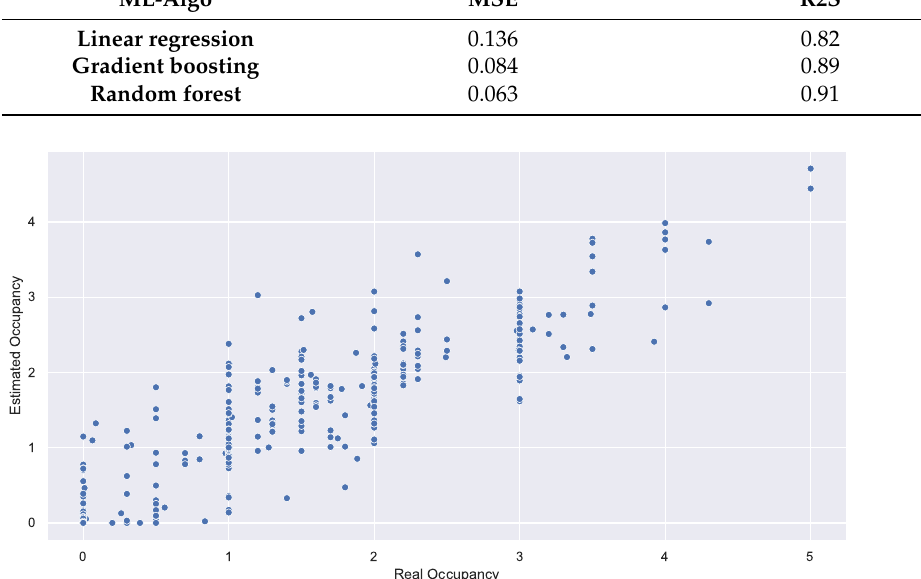
Figure 12. Estimated occupancy and real occupancy when considering random